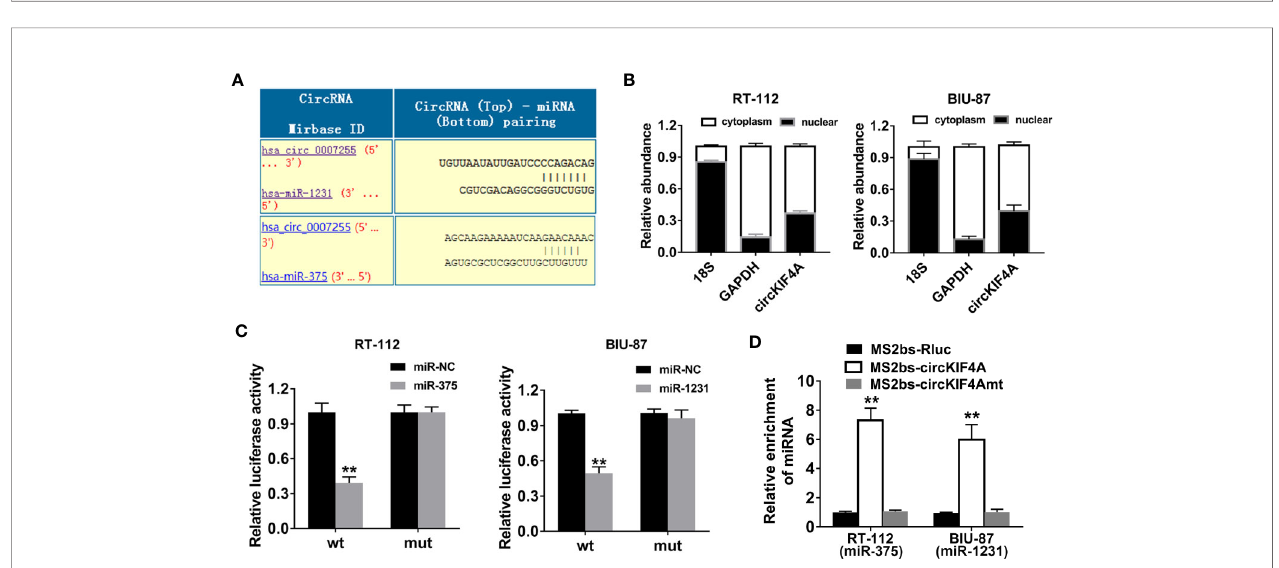
FIGURE 3 | circKIF4A functions as a sponge for miR-375 and miR-1231. (A) Prediction of the binding sites of miR-375 and miR-1231 in the circKIF4A sequence (https://circinteractome.nia.nih.gov). (B) The expression levels of 18S, GAPDH and circKIF4A in nuclear and cytoplasmic fractions. (C) Luciferase reporter assays were conducted. RT-112 and BIU-87 cells were cotransfected with miR-375/1231 mimics and circKIF4A wild-type or mutant luciferase reporter. (D) MS2-based RIP assay in RT-112 and BIU-87 cells transfected with MS2bs-circKIF4A, MS2bs-circKIF4A-mt or MS2bs-Rluc. **P <